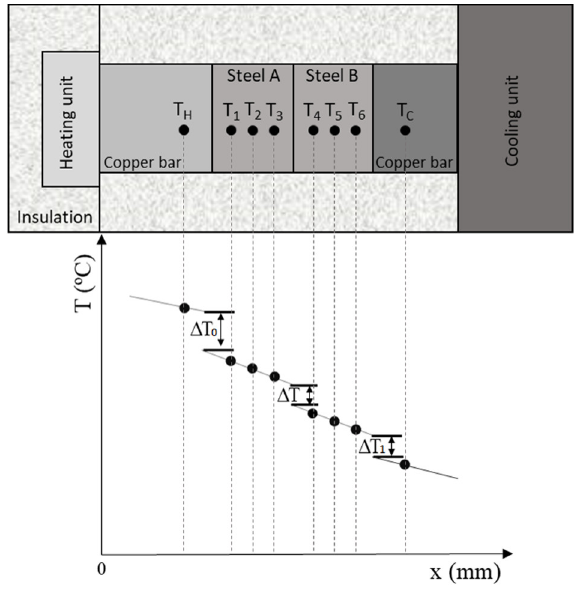
Figure 3. Schematic representation of thermocouple positioning in the experimental setup.